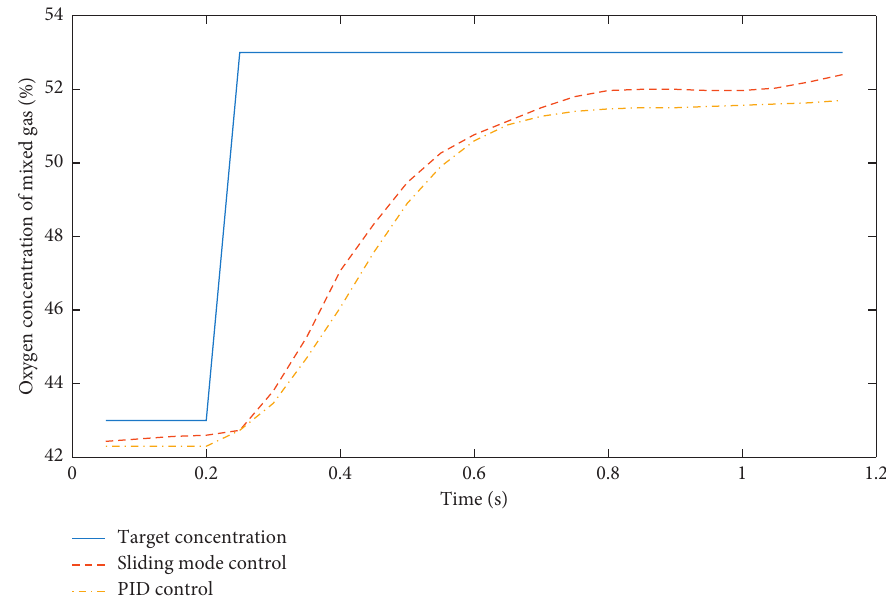
Figure 8: Comparison of actual gas oxygen concentration under 43–53% oxygen concentration adjustment range of mixed gas.